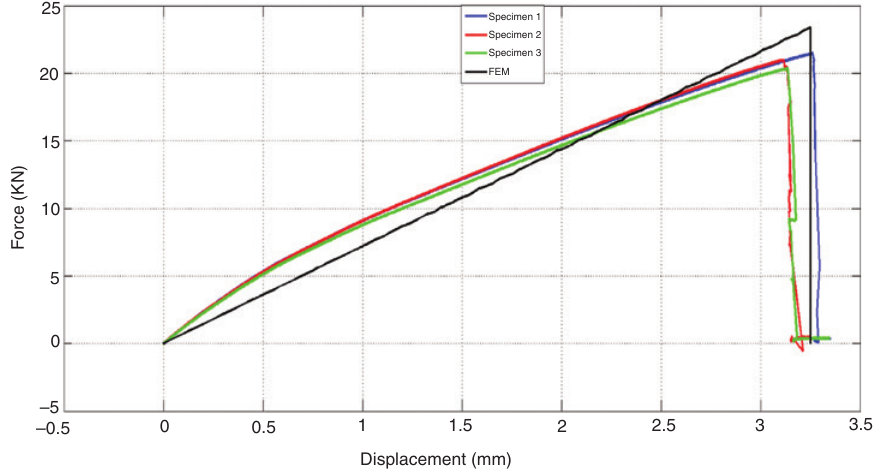
Figure 2: Load-displacement curves associated with FEM simulation and tensile tests.